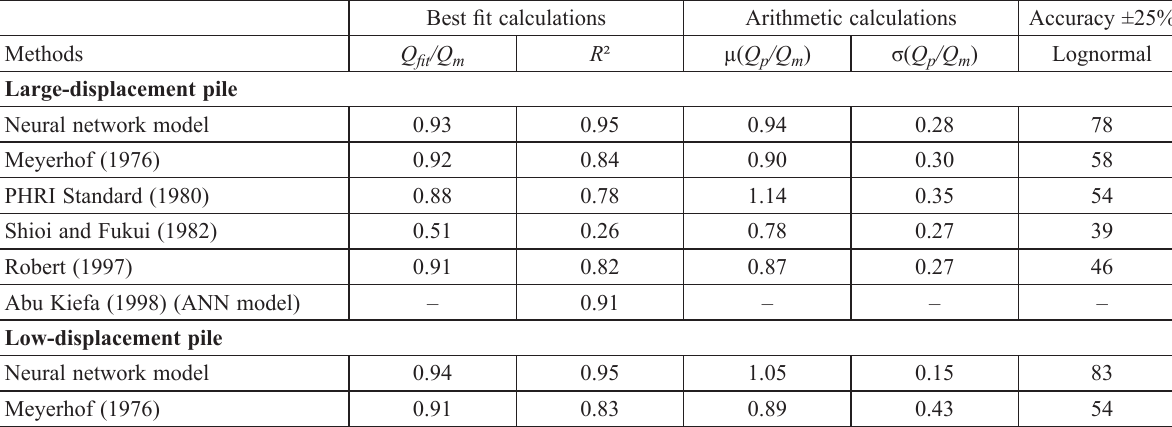
Note: Q fit – pile capacity of the best fit of predicted versus measured pile capacity; Q p – predicted pile capacity; Q m – measured pile capacity; µ – mean; σ – standard